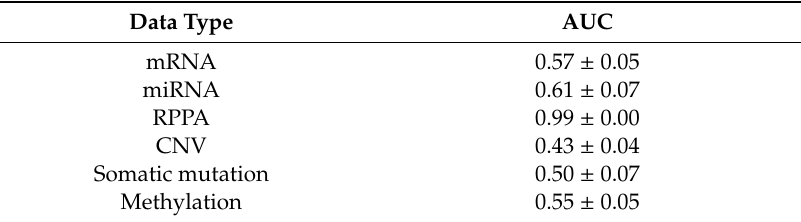
Figure 3. 3D-scatter plots of compressed common ID data belonging to one category. Each axis represents the data values and the color shows Cluster ID. ( a ) Methylation common data. ( b ) reverse phase protein array (RPPA) common data. ( c ) Somatic mutation common data. ( d ) miRNA common data. The Cluster ID are not separated in ( a , c , d ). In ( b ), the Cluster ID were separated clearly. Table 3. Area under curve (AUC) of logistic regression models for predicting the survival subtypes using compressed data.